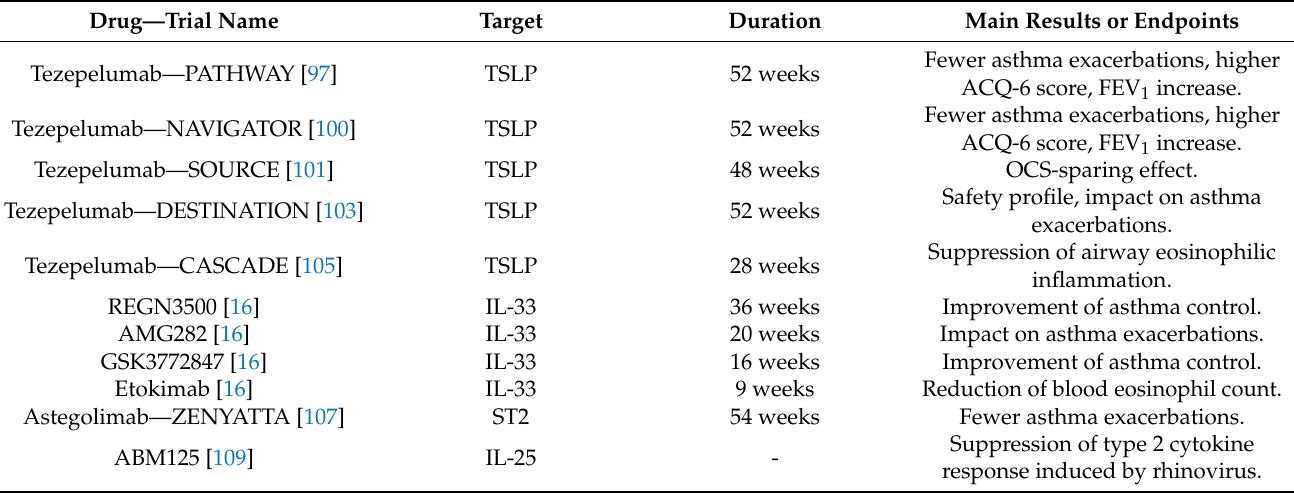
Table 1. Anti-alarmins: summary of the main